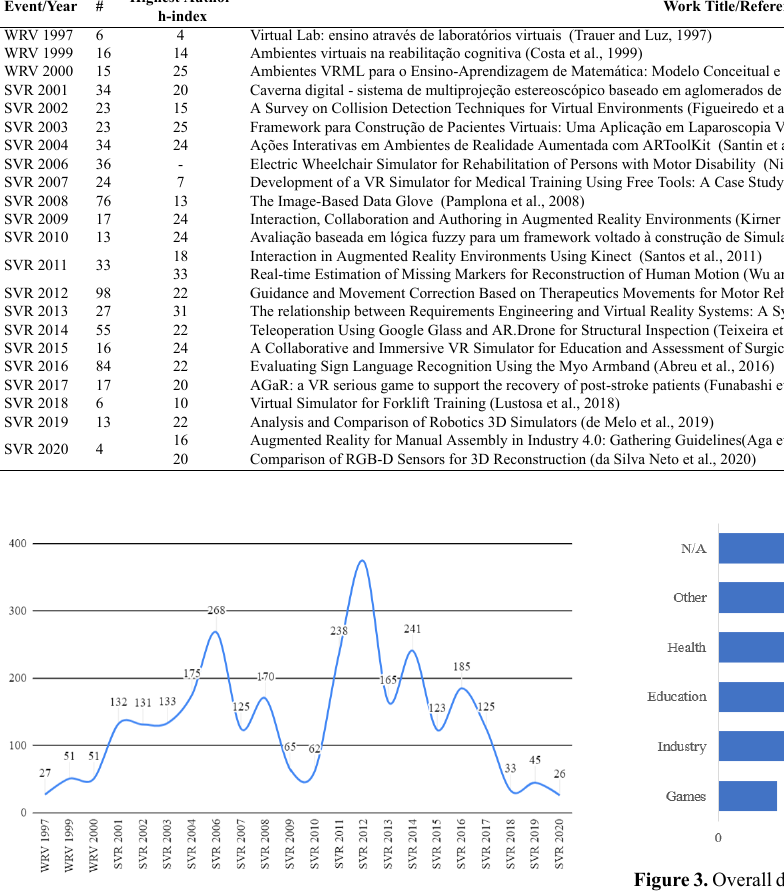
Figure 2. Evolution of the citation numbers per event (in chronological or- der).